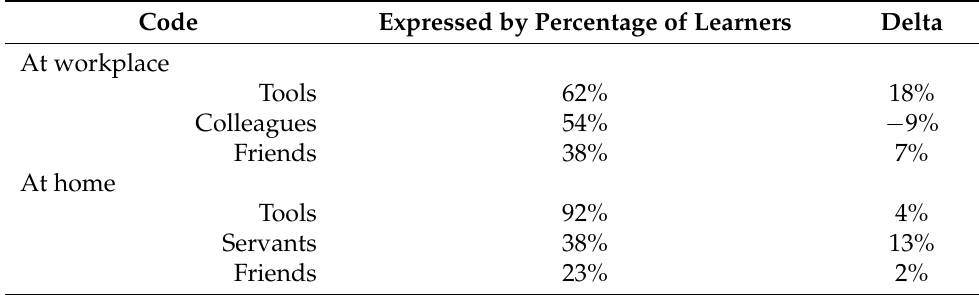
Table 1. Learners’ attitudes towards robots. The Delta column represents the deviation from the pre-workshop